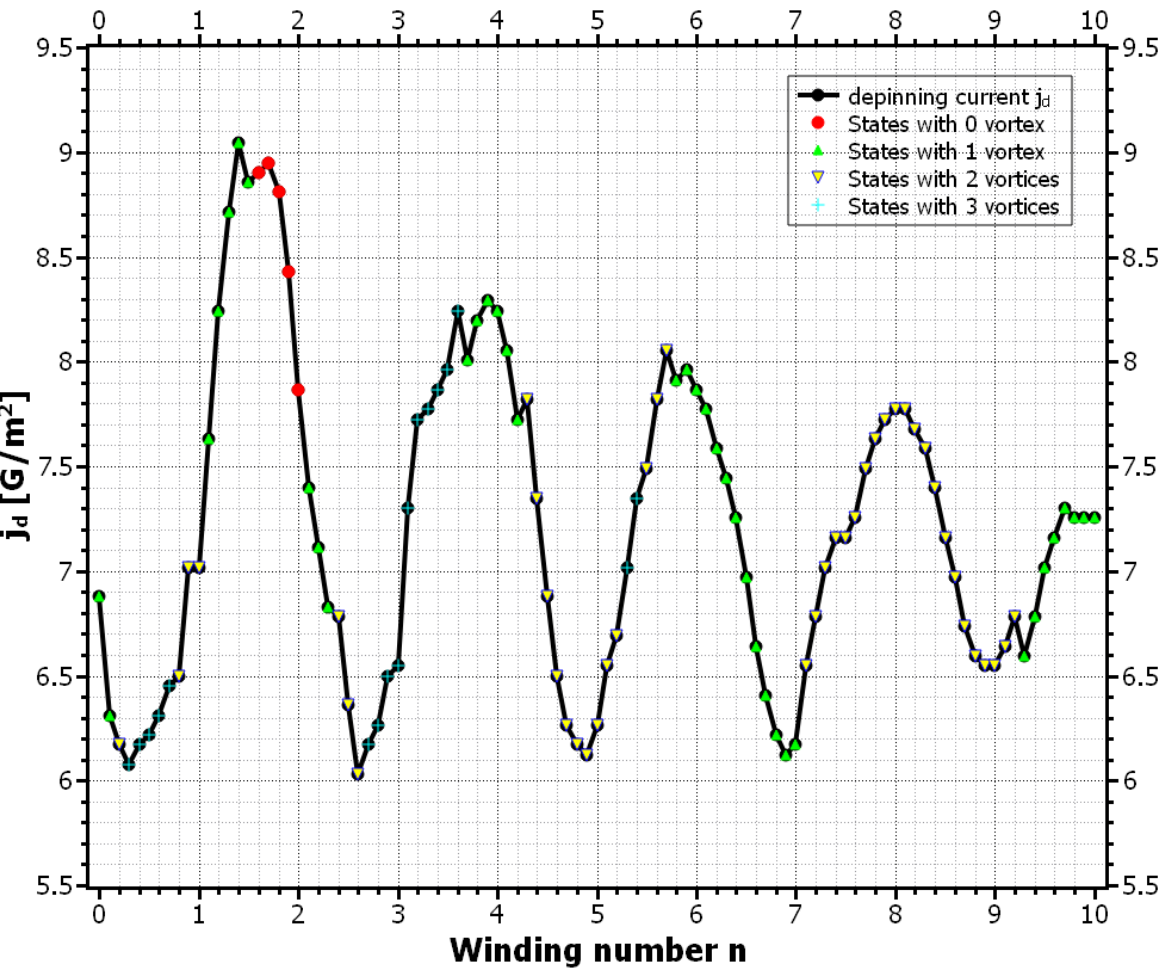
Figure 5. Depinning current versus the winding number for B e = 1.5mT, α = α s , and α 0 = 0.1¯ h / ξ GL . For j e ≤ j d the vortex motion is prevented, whereas for j e > j d the SC enters the resistive state. The shape of the approximate curve also depends on the number of vortices and has kinks where this number